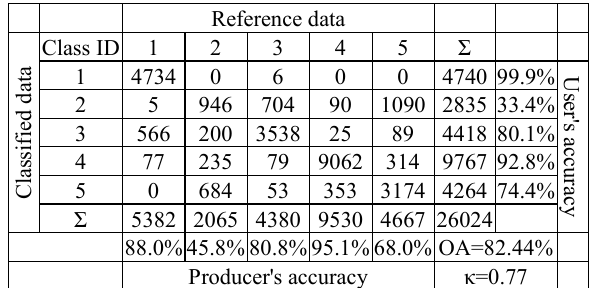
Table 2. Confusion matrix for land-cover classification based on the S-2 imagery